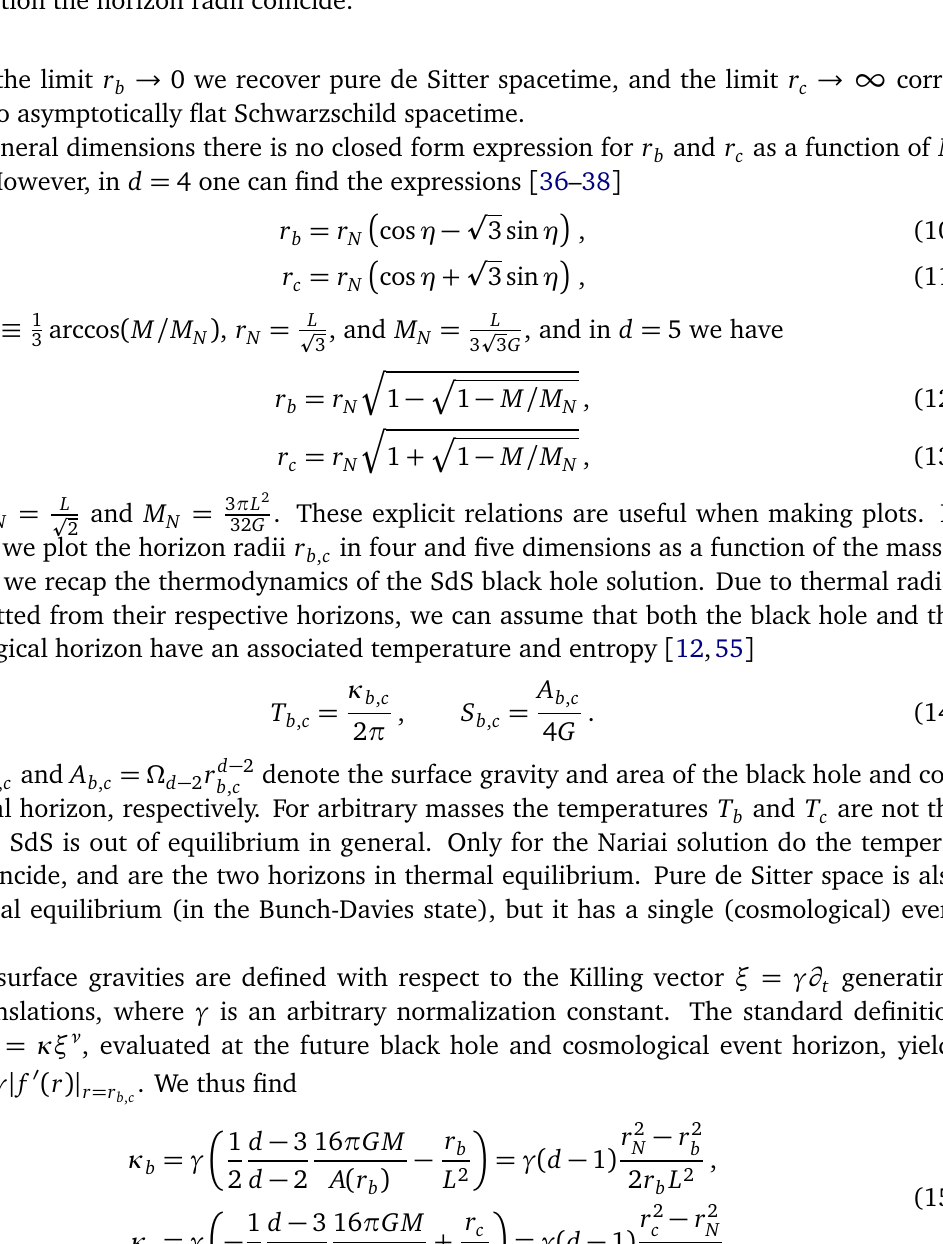
Figure 1: Horizon radii r in units of the de Sitter radius L vs. mass M in units b , c of the Nariai mass M , where we have set d = 4 (left) and d = 5 (right). The N black hole horizon radius (blue curve) becomes larger as M increases, whereas the cosmological horizon (orange curve) shrinks in size as M increases. For the Nariai solution the horizon radii